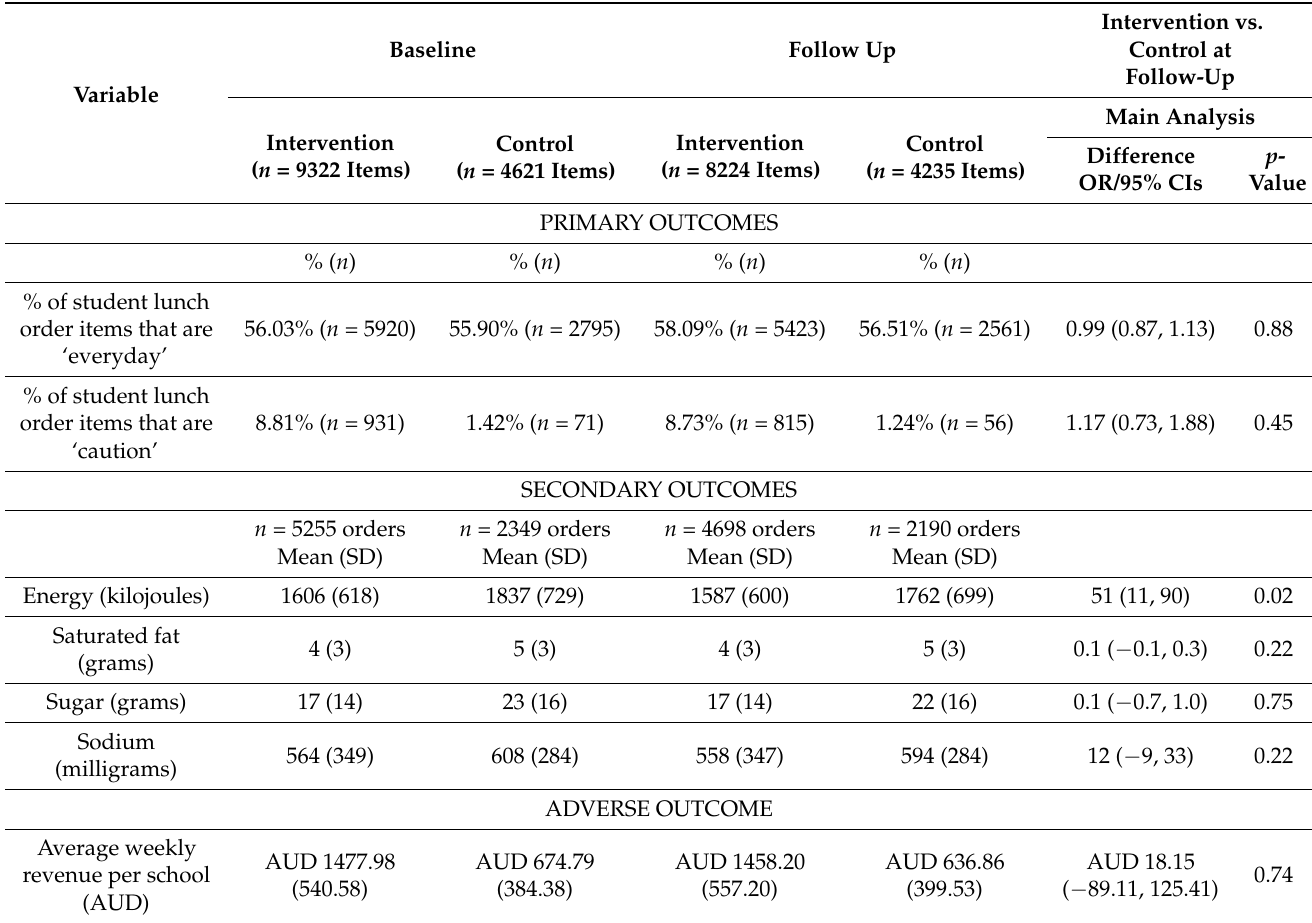
Table 2. Impact of intervention on primary and secondary outcomes in intervention and control groups at follow up, controlling for baseline